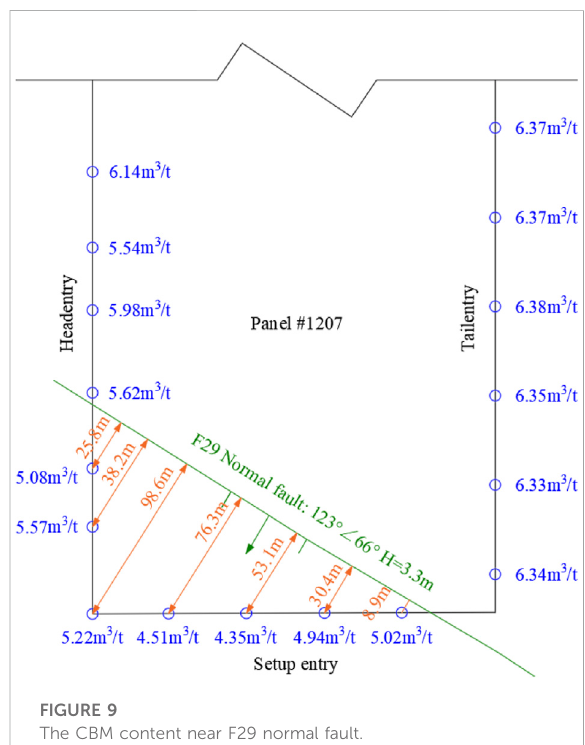
FIGURE 9 The CBM content near F29 normal